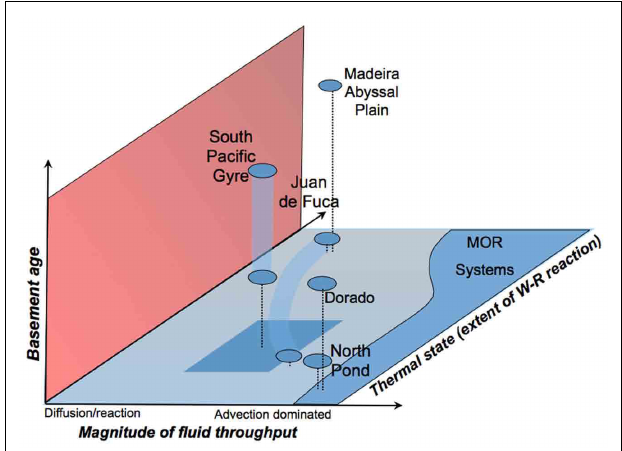
FIGURE 2 | Cartoon illustrating how ridge flank hydrothermal field areas discussed in this paper might vary in terms of three key physical and chemical parameters: age of basement rocks, magnitude of fluid flow through the crust, and then thermal state of the basement aquifer (which indicates the likely extent of water–rock interaction). Information used to construct this figure is listed in Table 1 ).The height of individual dots indicates basement age, whereas position on the horizontal space indicates fluid and thermal states.The South Pacific Gyre sites span a range of parameters (height of dots indicates range of basement ages, in addition to fluid and thermal state).There are two main parts of the eastern flank of the Juan de Fuca Ridge, indicated by the swath between two dots. Properties of many areas associated with mid-ocean ridges (MORs) are indicative of young basement age, a wide range of temperatures, and additional variability in fluid throughput, as shown.